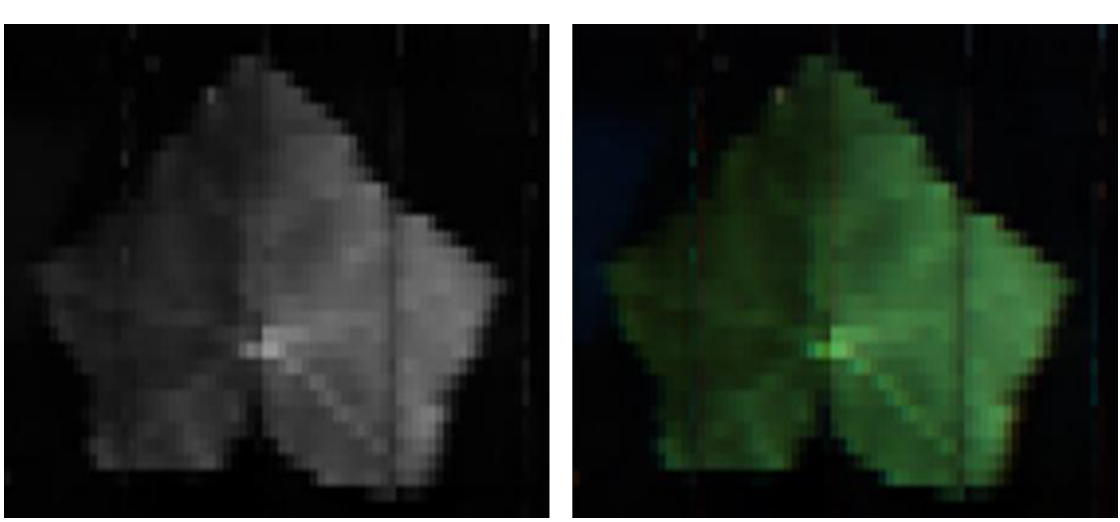
Figure 12. This figure shows an image of a leaf, reconstructed from an image, taken by the instrument, using the MATLAB software. The left picture shows a monochromatic image. The right picture shows an RGB image reconstructed using all of the bands of the datacube.